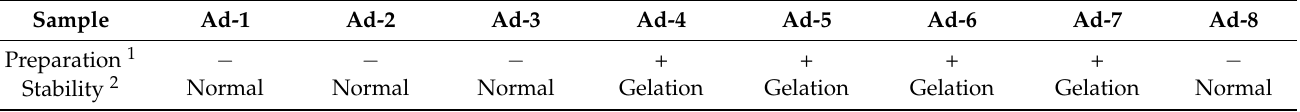
Table 5. The stability of coating including different